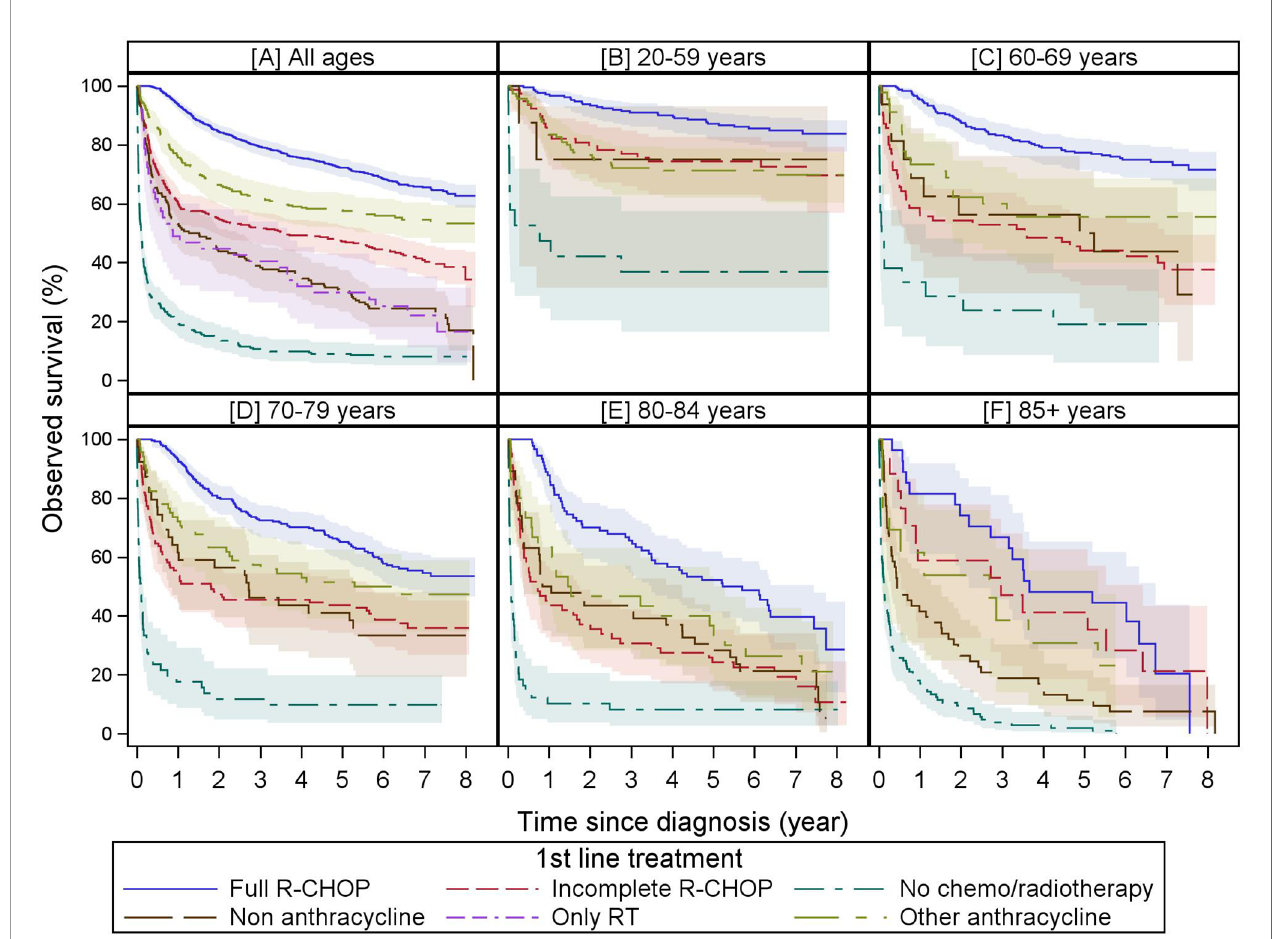
FIGURE 2 | Observed survival by fi rst-line treatment by age group. These Kaplan – Meier curves show the observed survival from diagnosis strati fi ed by fi rst-line treatment of all patients (A) and strati fi ed by age group (20 – 59, 60 – 69, 70 – 79, 80 – 85, and 85 years+ in ( B – F , respectively). For all age groups, full R-CHOP and “ no chemo/radiotherapy ” are consistently associated with the best and worst overall survivals, respectively. Immortal time bias is not taken into account as survival is presented from diagnosis and patients have to survive until the end of a treatment to be categorized as having received this treatment. While observed survival in the whole cohort for incomplete R-CHOP, other anthracycline, and non-anthracycline groups are signi fi cantly different, this is largely lost when strati fi ed by age except in the oldest age category. Due to low numbers, overall survival for radiotherapy alone is only displayed for the whole cohort. Colored areas represent the 95% con fi dence